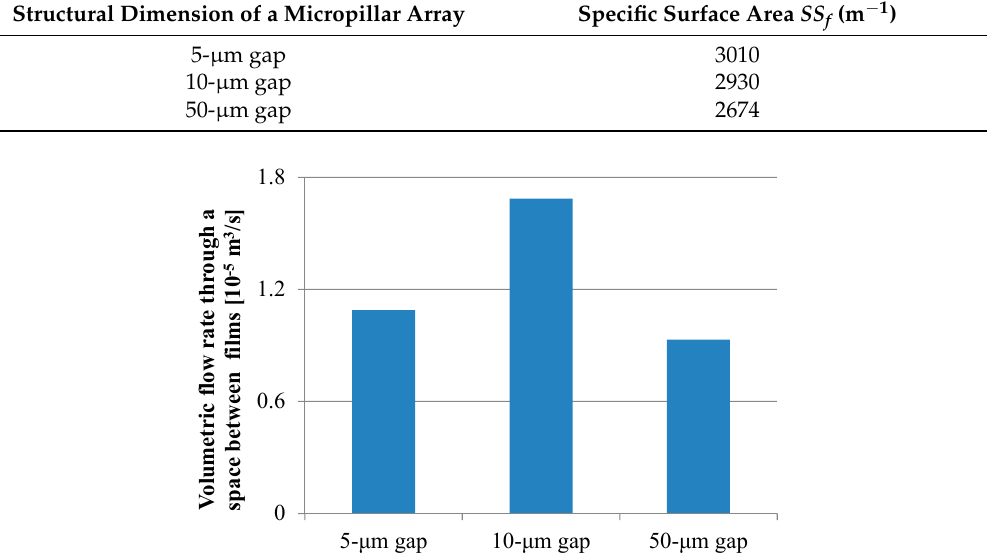
Figure 10. ( a ) Reaction efficiency of the film-stack reaction field calculated using Equation (13). ( b ) Volumetric flow rate contributing to the reaction or adsorption of the biomolecules in the wells with the film-stack reaction field calculated using Equation (14). 4. Discussion Although the characteristic length of the reaction efficiency given by Equation (13) is the hydrodynamic diameter in the model of Figure 6, the biomolecules, in fact, preferentially adsorb on the wall closest to the biomolecules’ position. Figure 11 shows a schematic image of the situation indicating the biomolecule adsorption on the wall, which exists in the space between the films of the film-stack reaction field. While the biomolecules preferentially adsorb on the micropillar walls in the